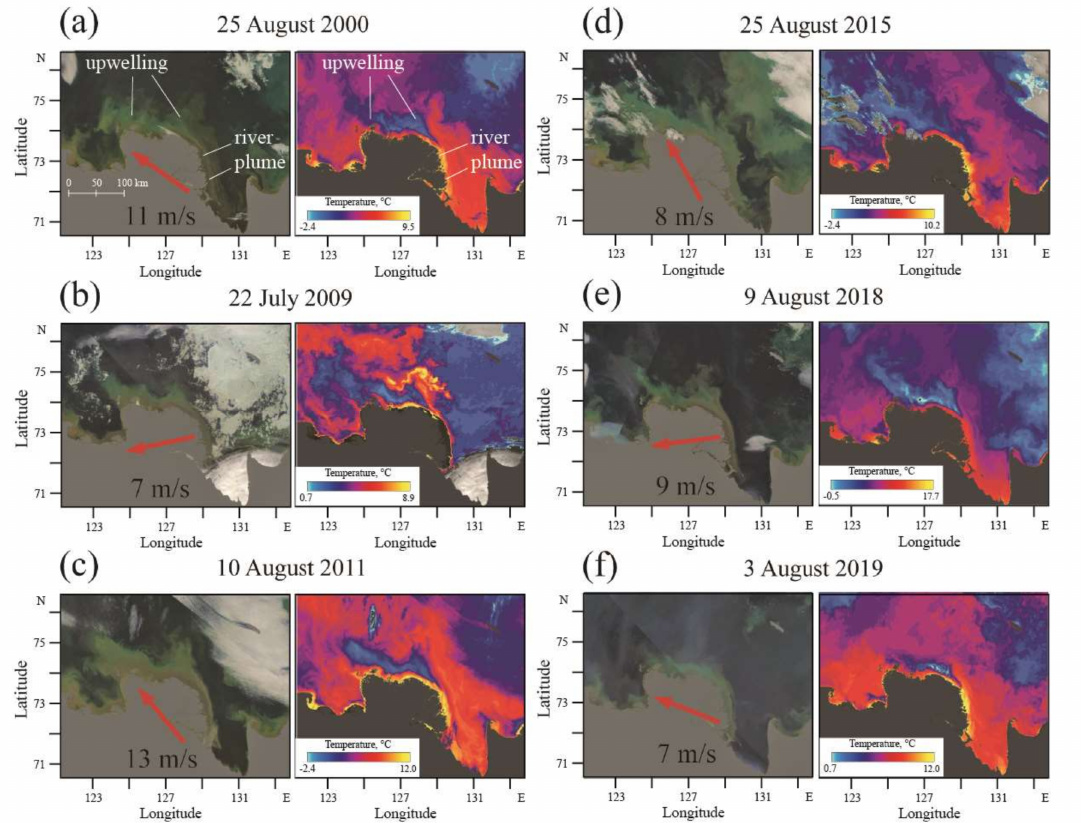
Figure 2. Corrected reflectance (left) and brightness temperature (right) from MODIS (Moderate Resolution Imaging Spectroradiometer) Terra and MODIS Aqua satellite images of the Laptev Sea acquired on ( a ) 25 August 2000, ( b ) 22 July 2009, ( c ) 10 August 2011, ( d ) 25 August 2015, ( e ) 9 August 2018, and ( f ) 3 August 2019 indicating the location of upwelling events to the north of the Lena Delta induced by wind forcing (arrows) and manifested by elevated sea surface turbidity and reduced sea surface temperature. Surface manifestations of upwelling events and river plumes are indicated in panel ( a